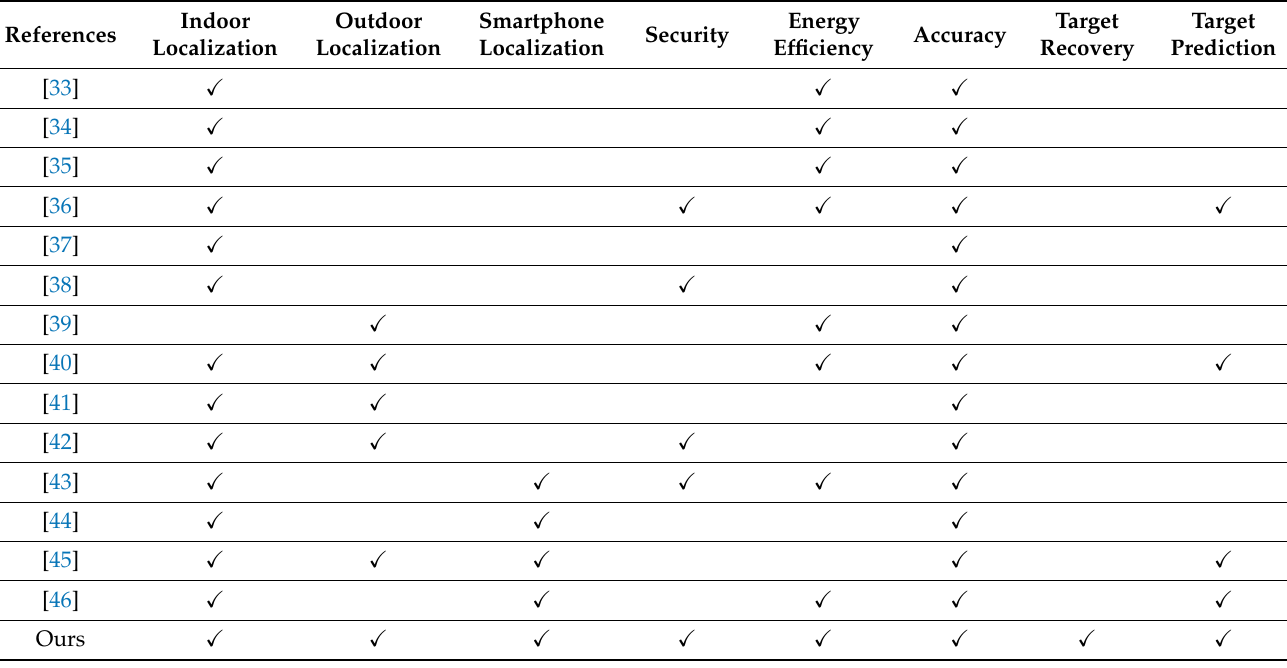
Table 3. Comparison between this paper and published surveys.